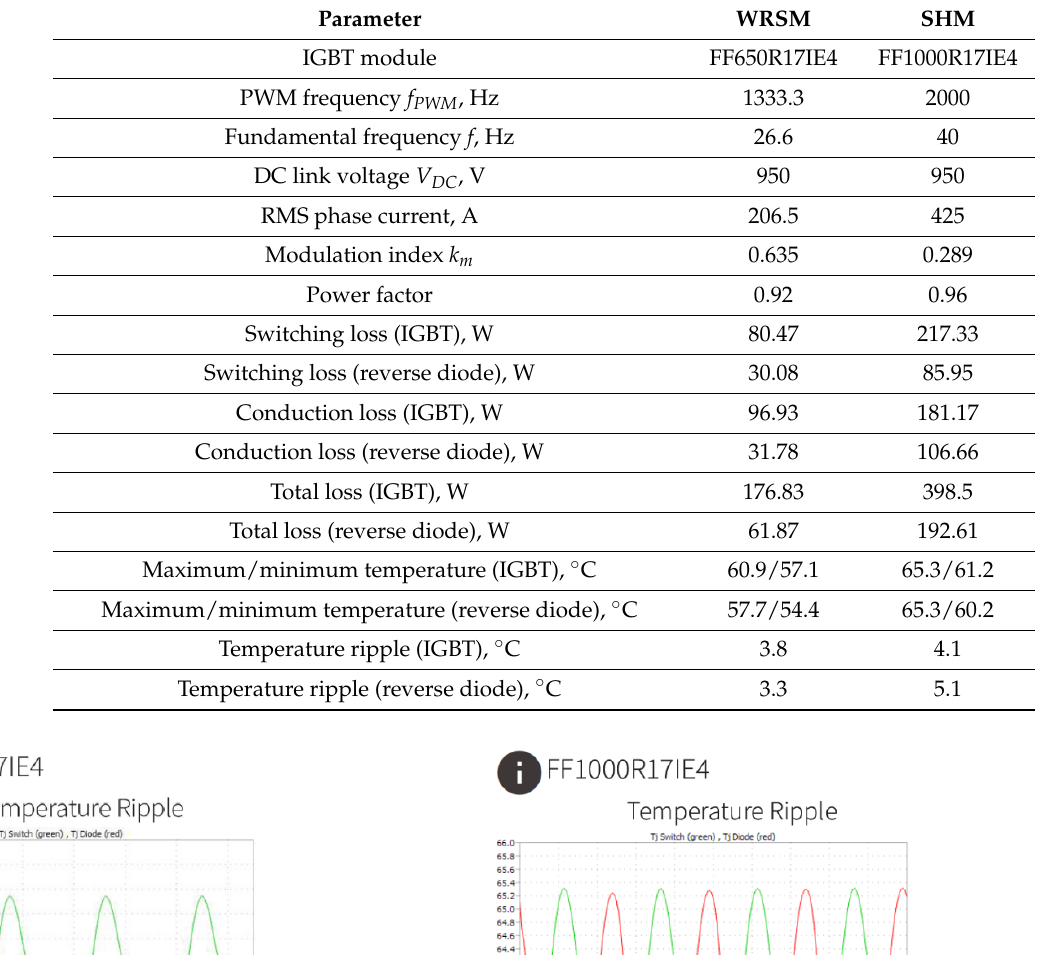
Table 7. Comparison of calculated characteristics of the WRSM and SHM after optimization.